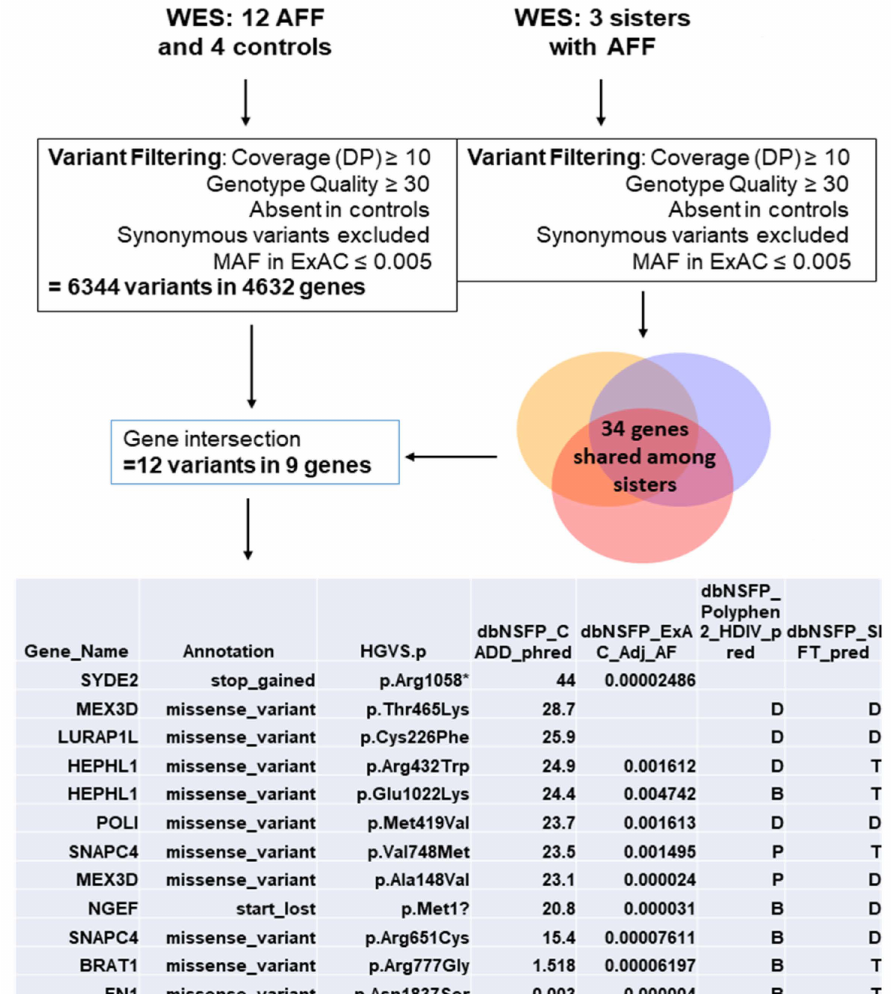
Figure 2. All mutated genes from the WES were intersected with genes also mutated in a previous study with 3 sisters who sustained AFF